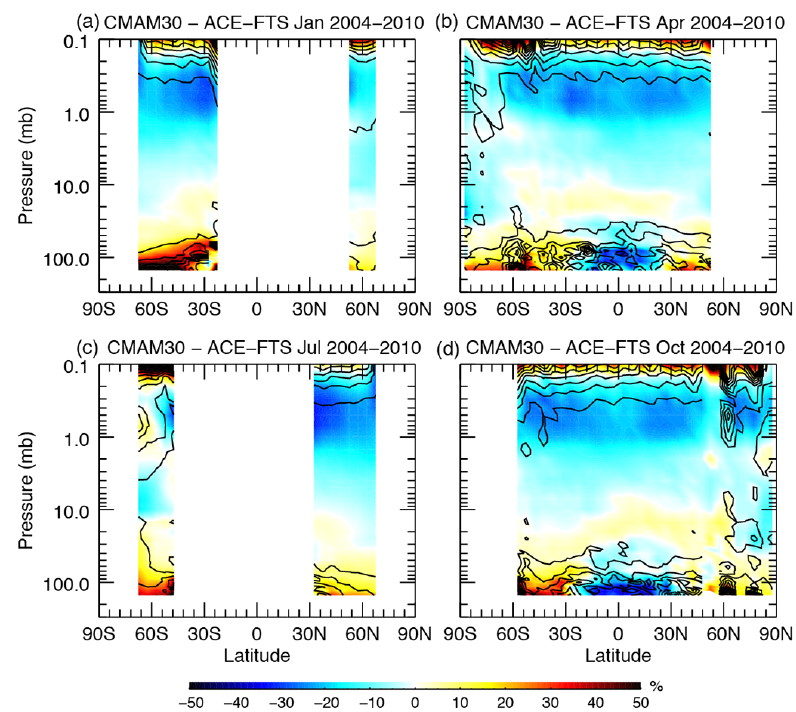
Figure 4. Same as for Fig. 2 but for CMAM30 vs. ACE-FTS relative differences for ozone profiles for 2004 to 2010.